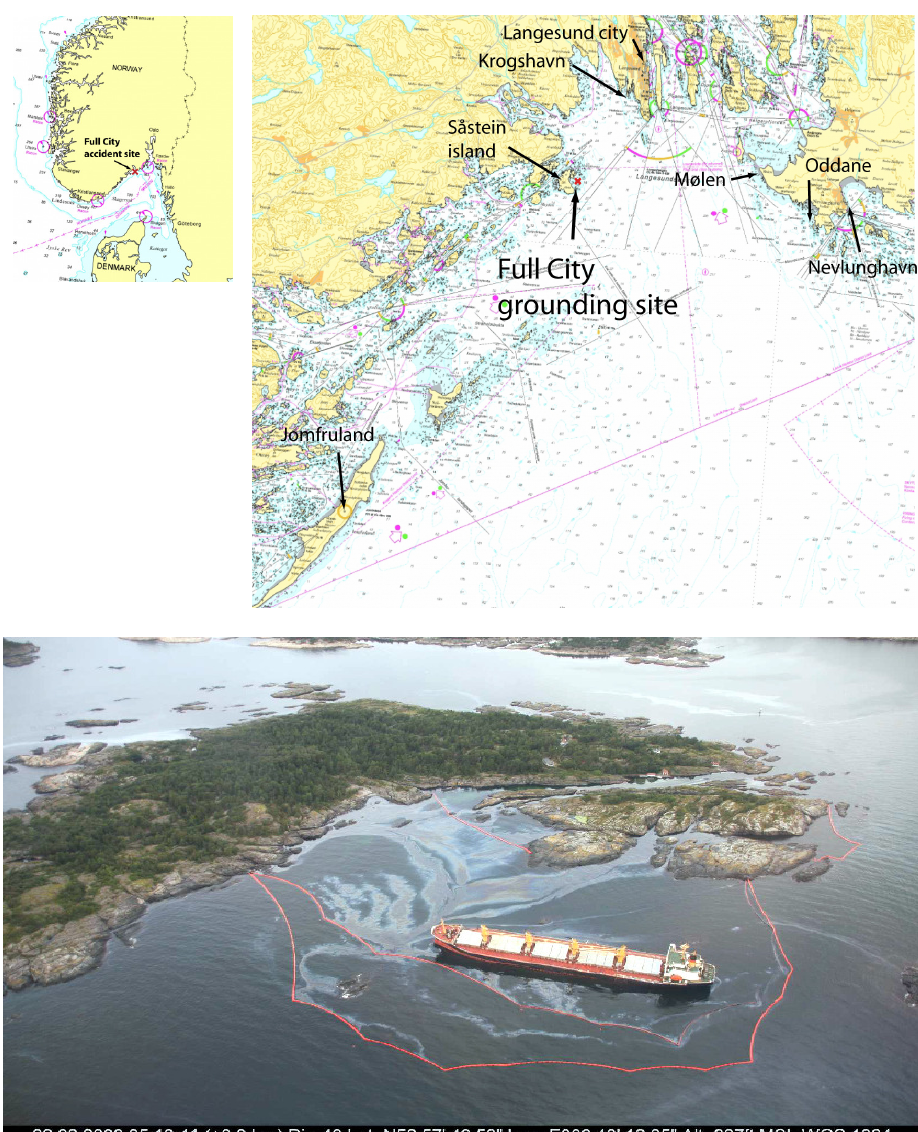
Figure 1: a) Location of the Island Såstein in Skagerrak area where the ship «Full City» grounded. b) Picture of the MV «Full City» outside Såstein on August 2. (Photo: NCA) By 12 August NCA claimed that 860 m 3 of oil had been recovered from the ship, 28 m 3 pure oil from the sea, 74 m 3 from the beaches, and 180 tons of oil emulsions had been recovered from the beaches and sea; accordingly, it is estimated that about 190 tons of oil remained in the environment